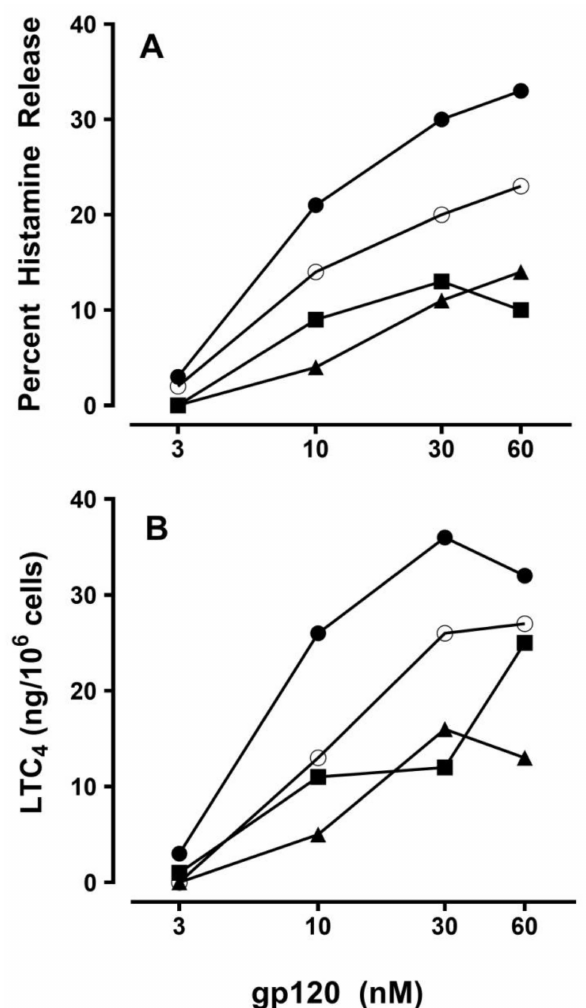
Figure 5. E ff ect of increasing concentrations of human immunodeficiency virus (HIV) gp120 on mediator release from four di ff erent preparations of HHMCs. HHMCs were incubated (45 min at 37 ◦ C) with the indicated concentrations of gp120. At the end of incubation, the concentrations of histamine ( A ) and LTC 4 ( B ) were measured in the four supernatants. Each point shows the mean of duplicate determinations. Each symbol represents the results from an individual